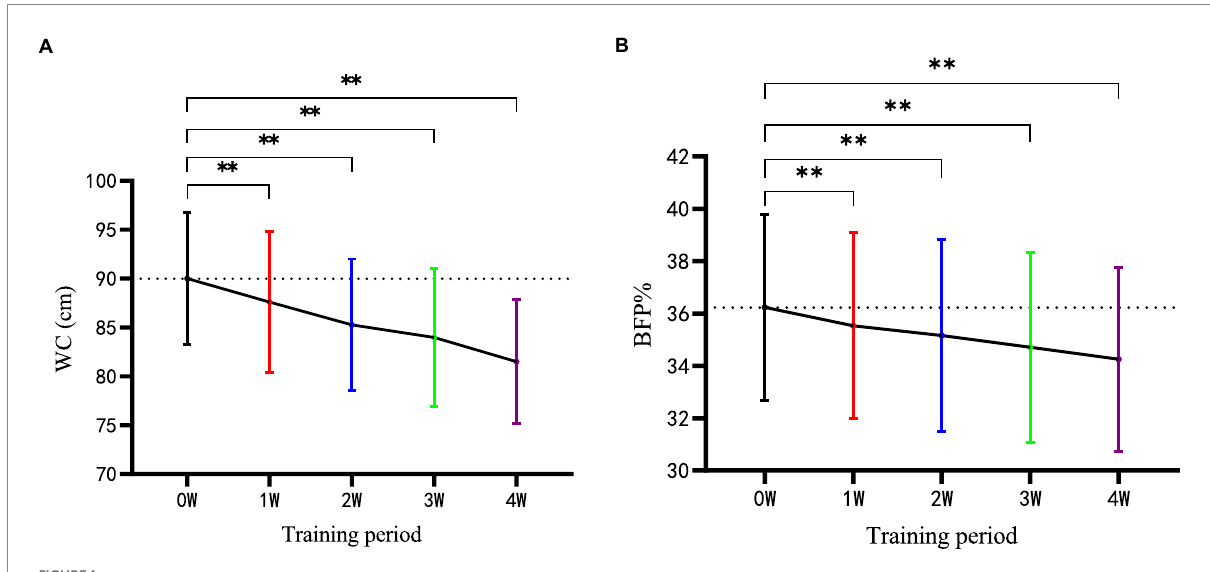
FIGURE 1 (A,B) Weekly measurement of body composition in the HIIT group during the four-week training (WC, waist circumference; BF %, body fat percentage). W, week; kg, kilogram; ** p <